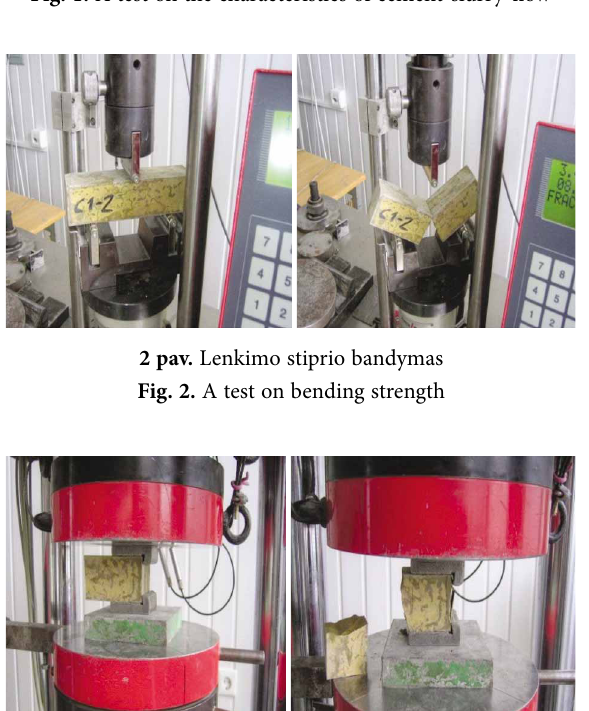
Fig. 1. A test on the characteristics of cement-slurry-flow